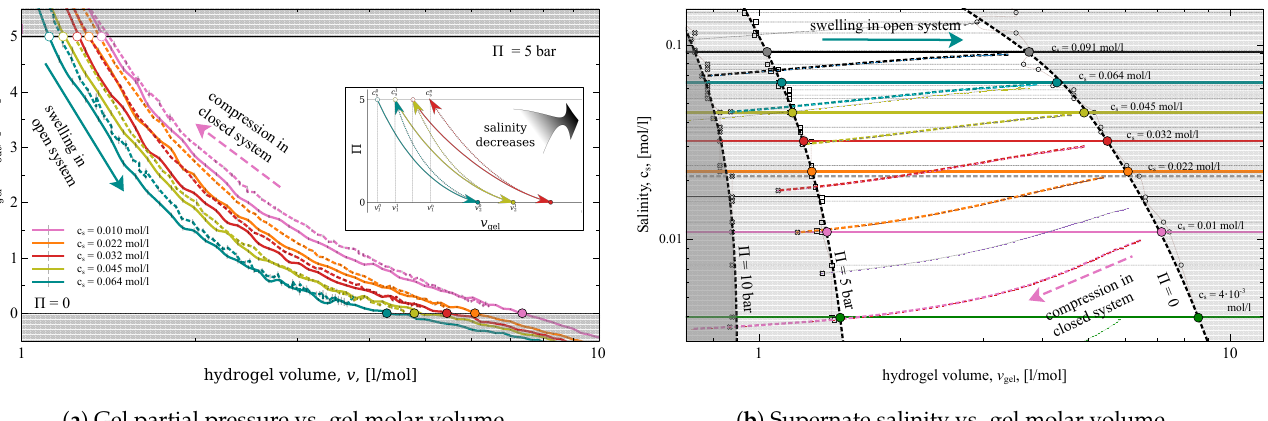
( b ) Supernate salinity vs. gel molar volume Figure 2. Compression of the gel in the open system (solid lines) and in the closed system (dotted lines). Each solid curve corresponds to different salinity of the reservoir c s (see legend). The shaded areas limit the states with applied pressure below zero and above 5